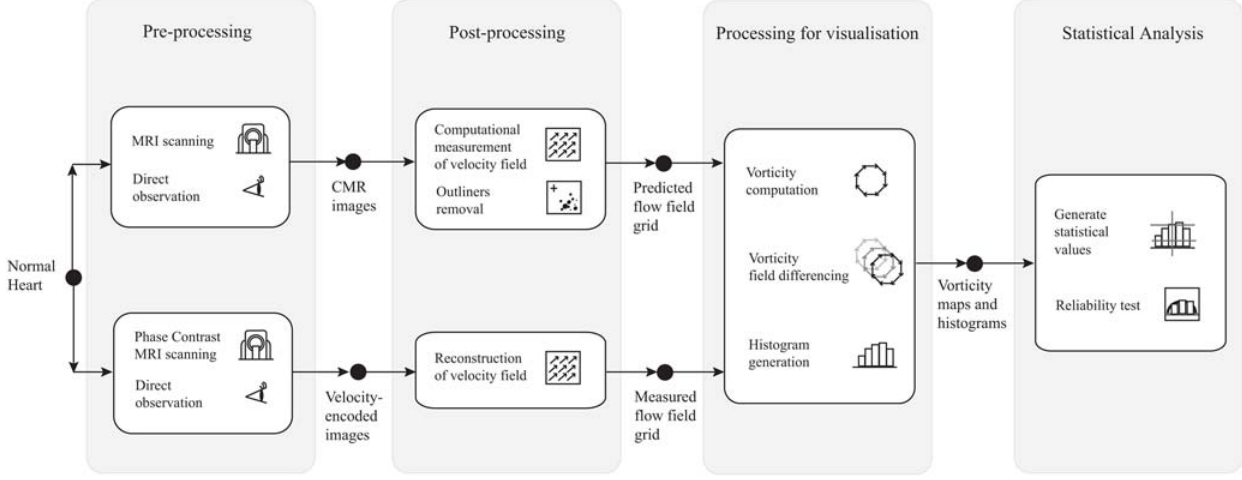
Figure 11. Reliability test system for MR fluid motion tracking based on vorticity differencing. This system is specially constructed to calibrate the performance of MR fluid motion tracking against the well-established phase contrast MR image velocimetry system. Pixel by pixel subtraction followed by scaling is performed to produce the vorticity field difference (or error) map.